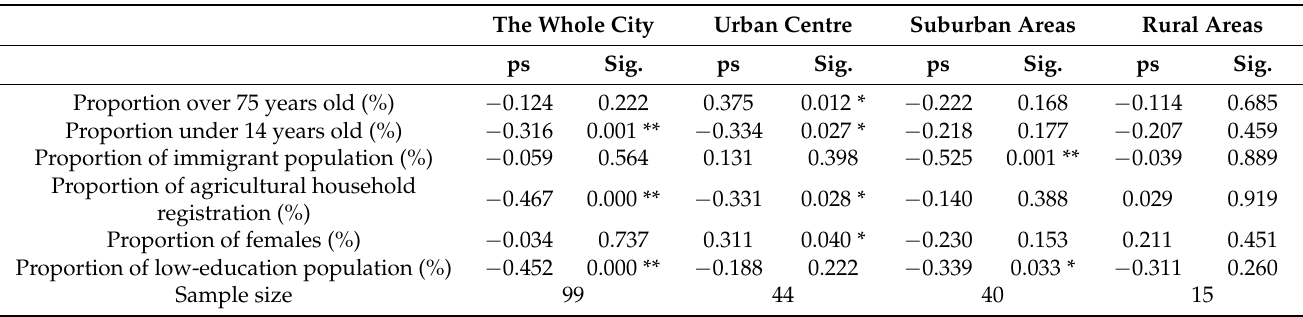
Table 3. Bivariate correlation analysis of flood risk and explanatory variables. The Whole City Urban Centre Suburban Areas Rural Areas